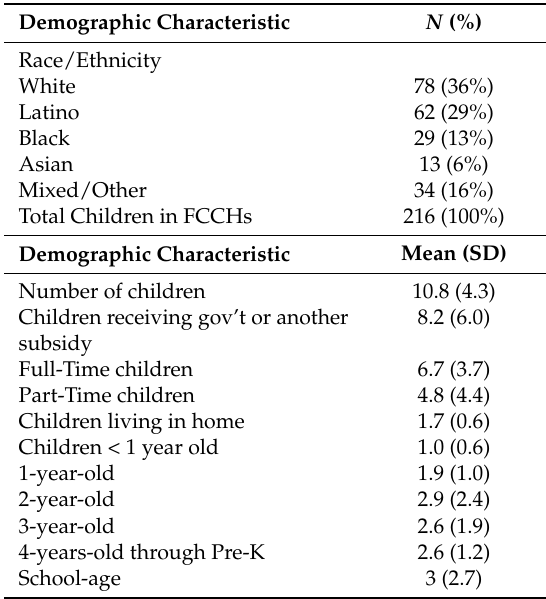
Table 3. FCCH Child Demographics, N = 20.